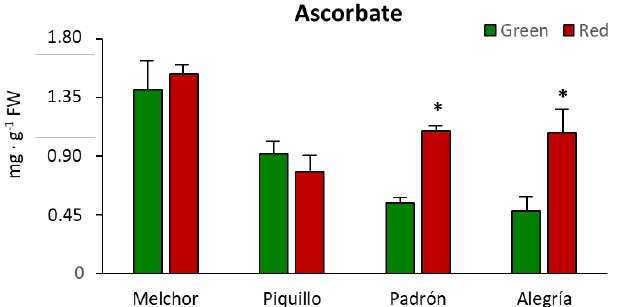
Figure 2. Ascorbate content in pericarp from fruits of four pepper varieties at two ripening stages. Data are the means ± SEM of three replicates determined from five fruits of the four varieties and at the two ripening stages. Asterisks indicate significant differences of red fruits with respect to green fruits for each variety ( t -student, p < 0.05). FW, fresh weight.